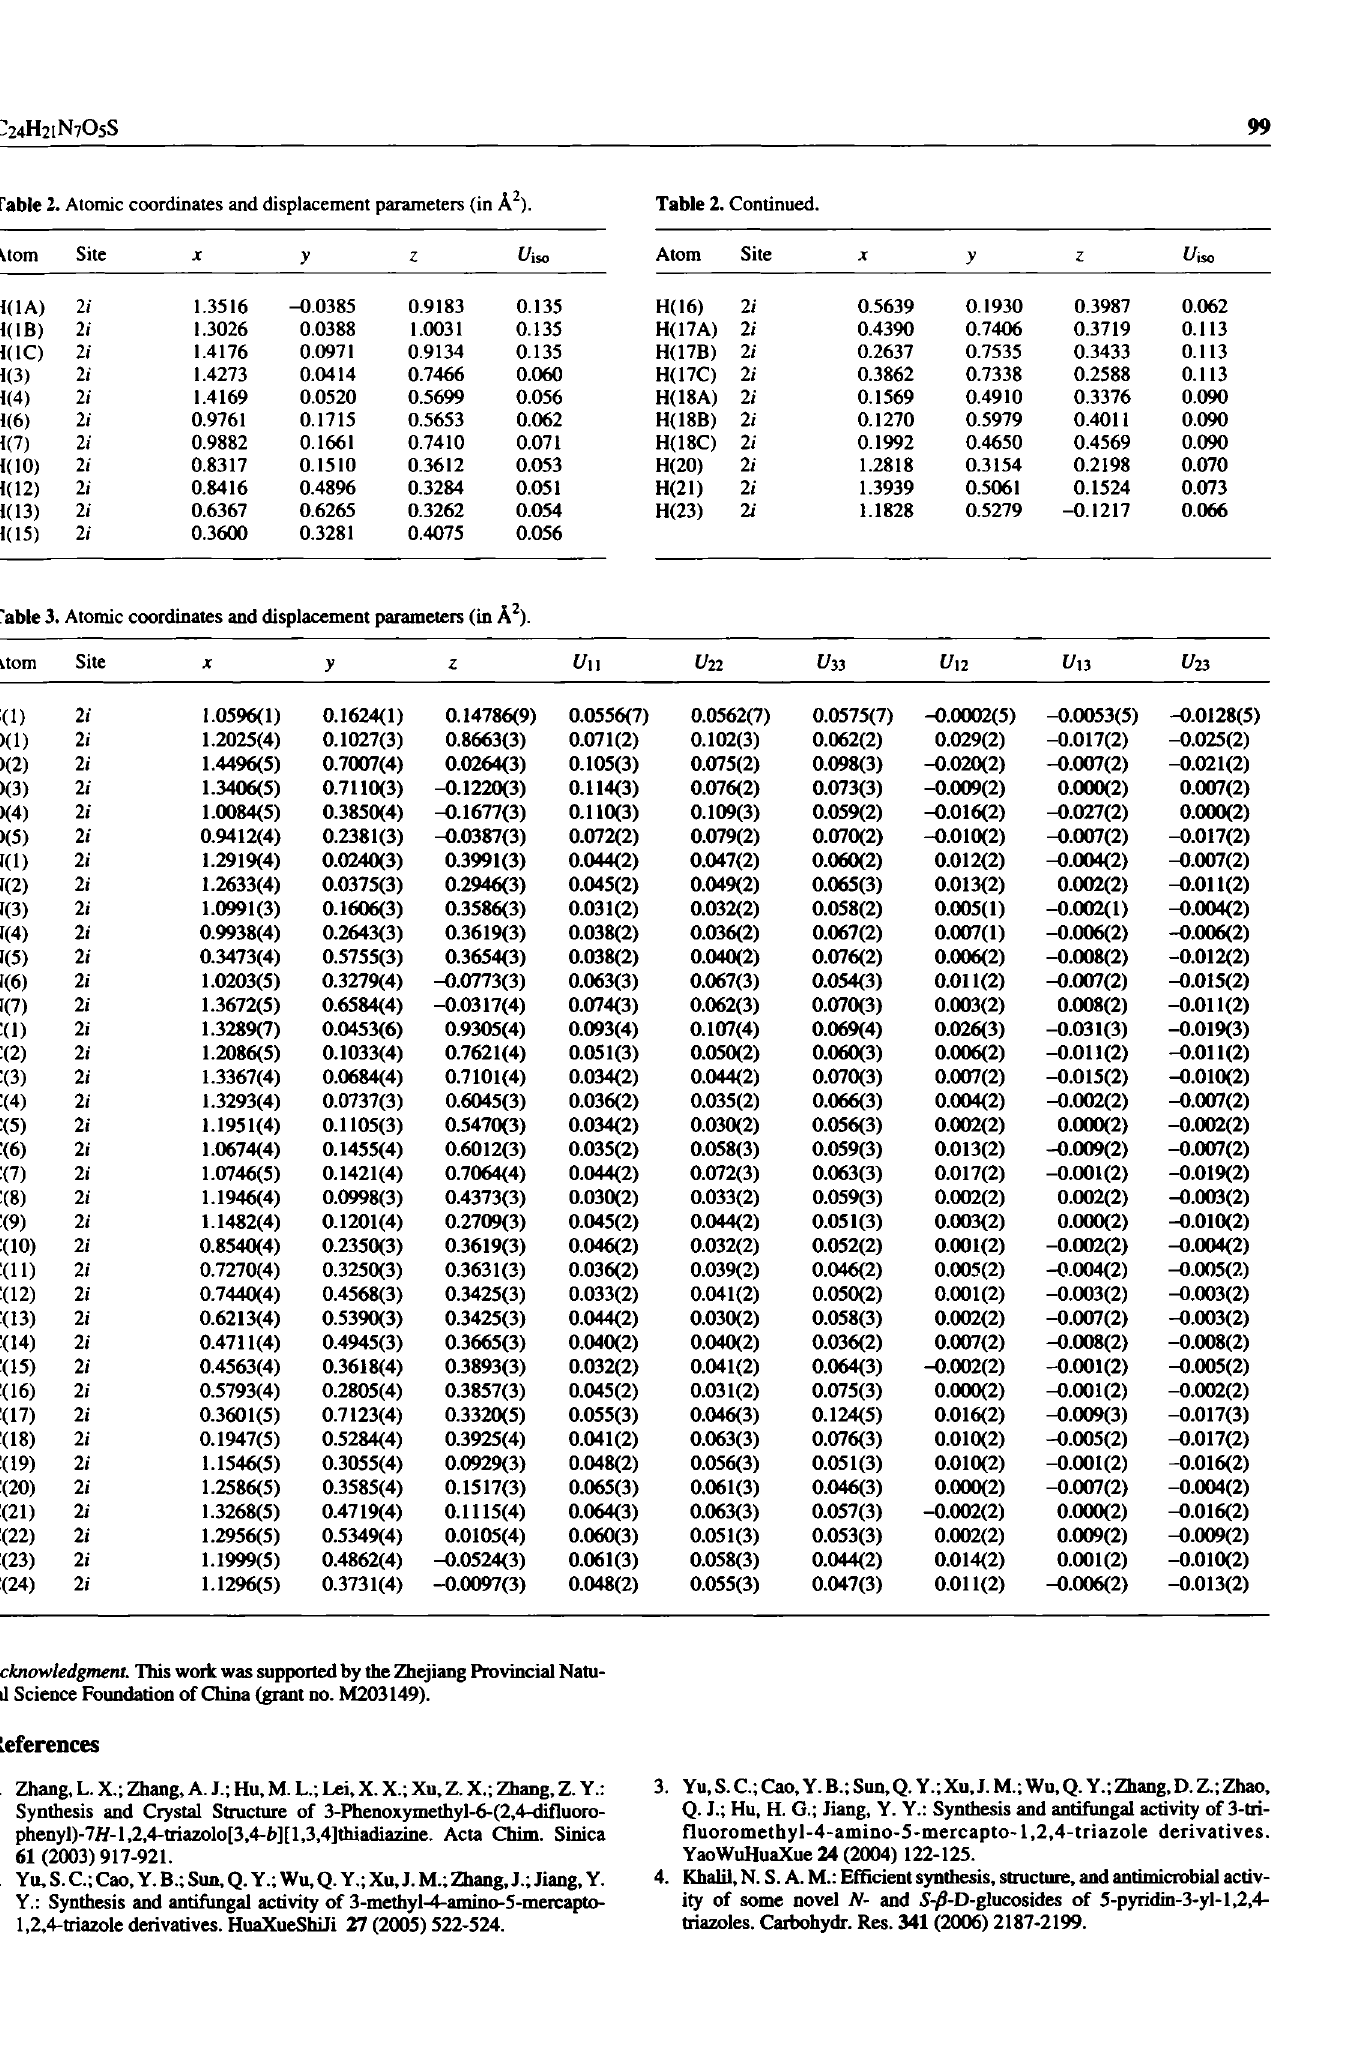
Table 3. Atomic coordinates and displacement parameters (in Ä 2